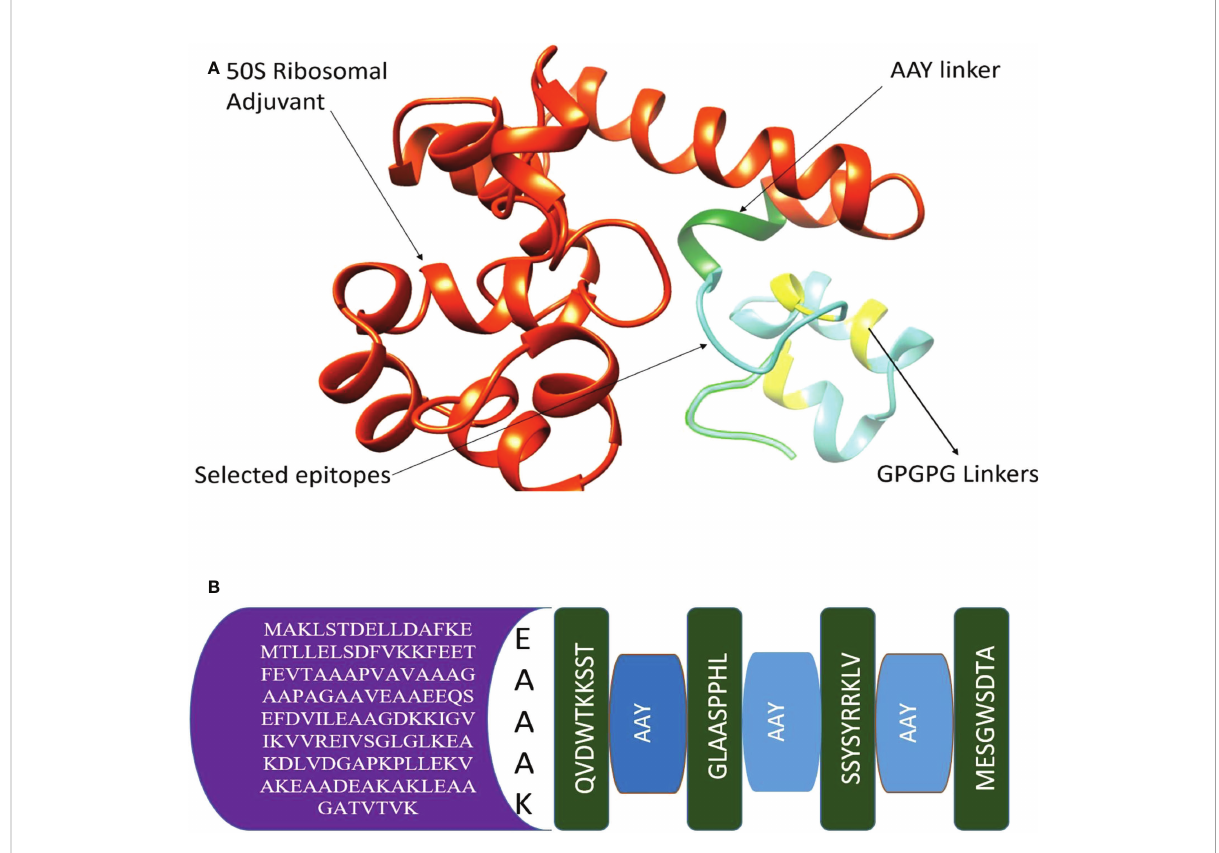
FIGURE 3 (A) 3-D structure of chimeric vaccine (B) Adjuvant, EAAAK, AAY linkers, and selected